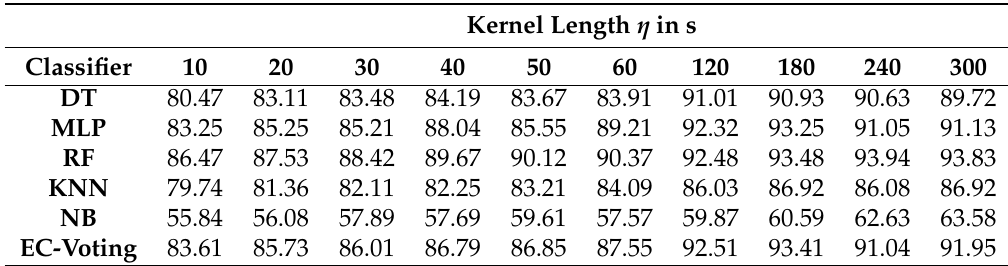
Table 2. Average accuracy (%) in Layer 1 for near-real time mode detection using GPS, inertial measuring units (IMU) and spatial information.